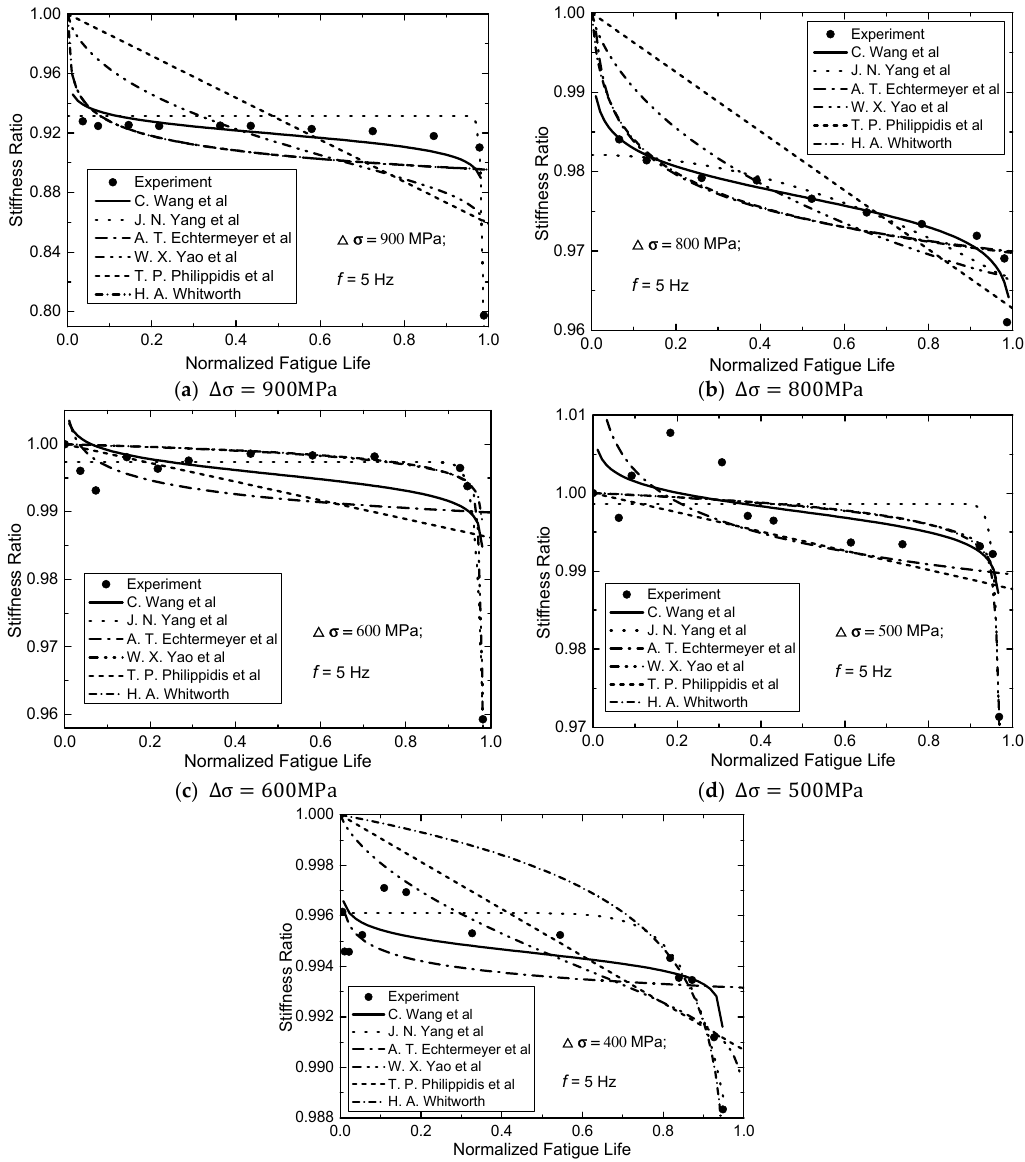
Figure 4. Predicted and measured residual stiffness of CFRP tendons at different stress ranges: ( a ) ∆σ = 900MPa, ( b ) ∆σ = 800MPa, ( c ) ∆σ = 600MPa, ( d ) ∆σ = 500MPa, ( e ) ∆σ = 400MPa.